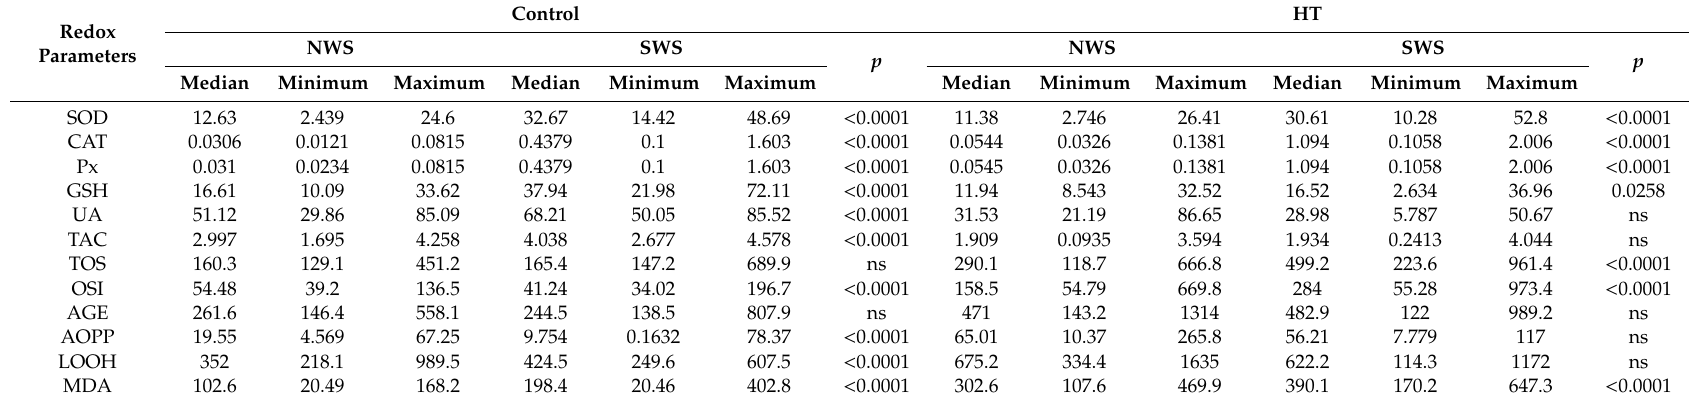
Table 3. Comparison of NWS to